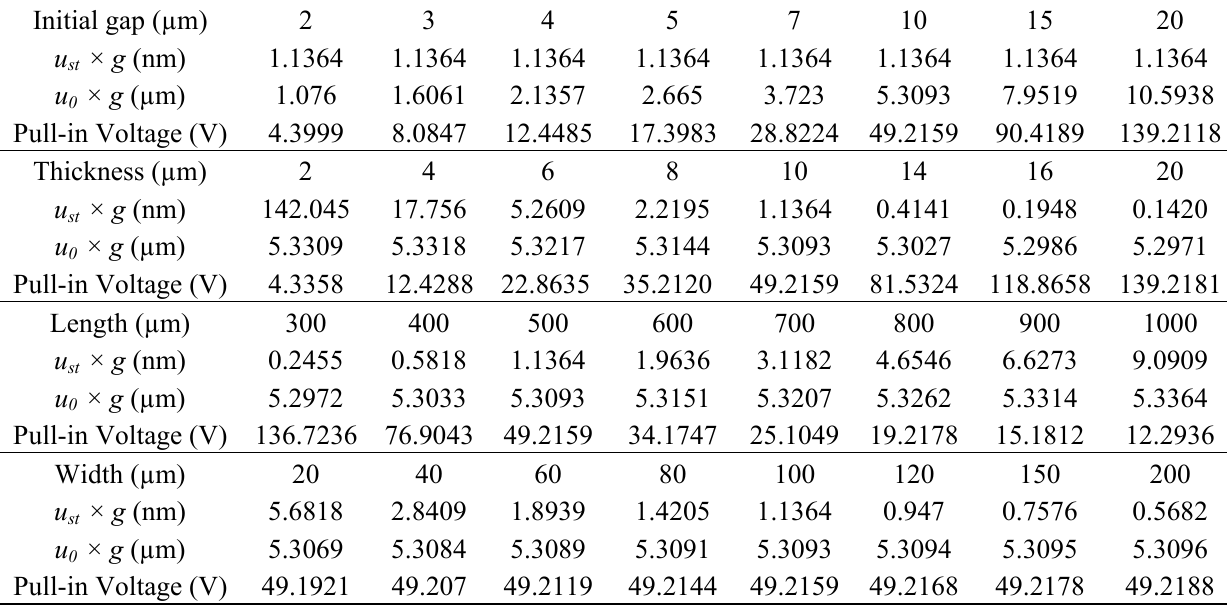
Table 4. Influence of geometric parameters on pull-in voltage and deformation of proposed microcantilever sensor with electrostatic excitation ( u excitation ( u × g ). The applied force is equal to 1 nN and the reference microcantilever st data has been used for simulation.